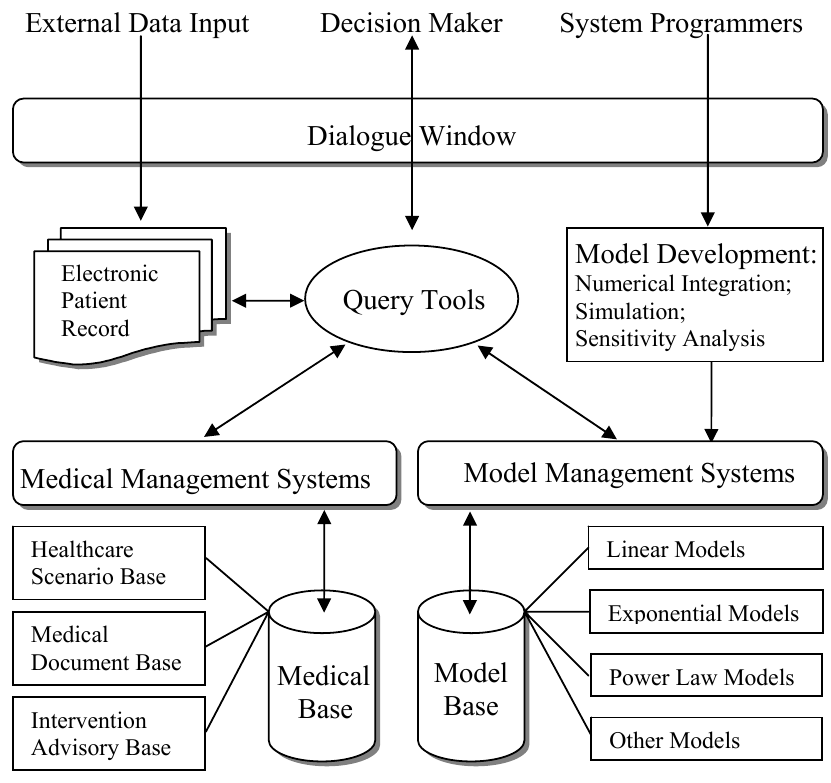
Fig. 2 The framework of